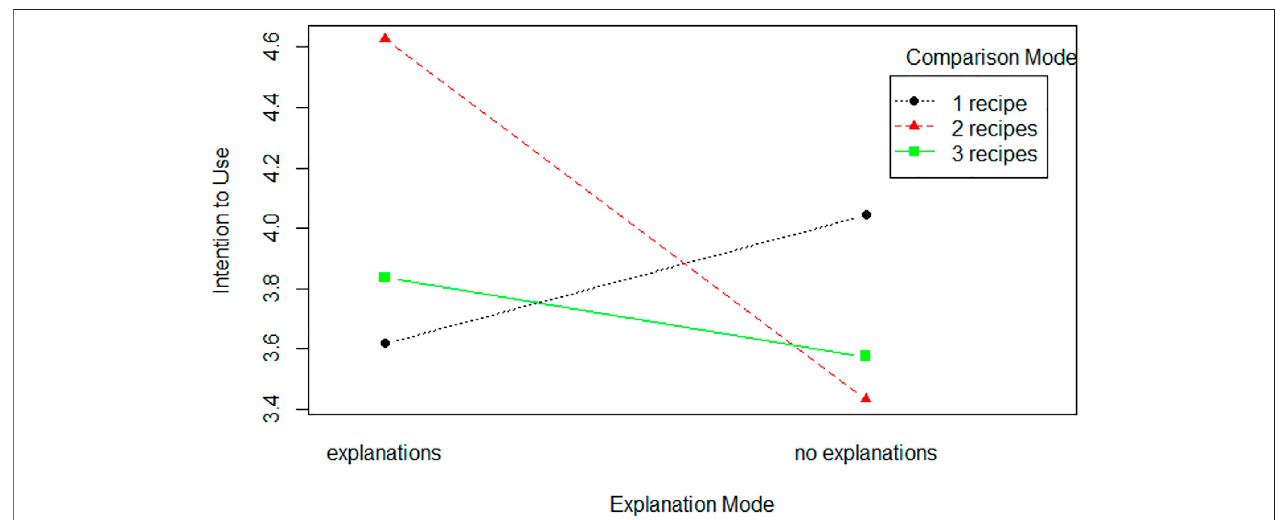
FIGURE 9 | Interaction between explanation mode and comparison mode on users ’ intention to use Cora.